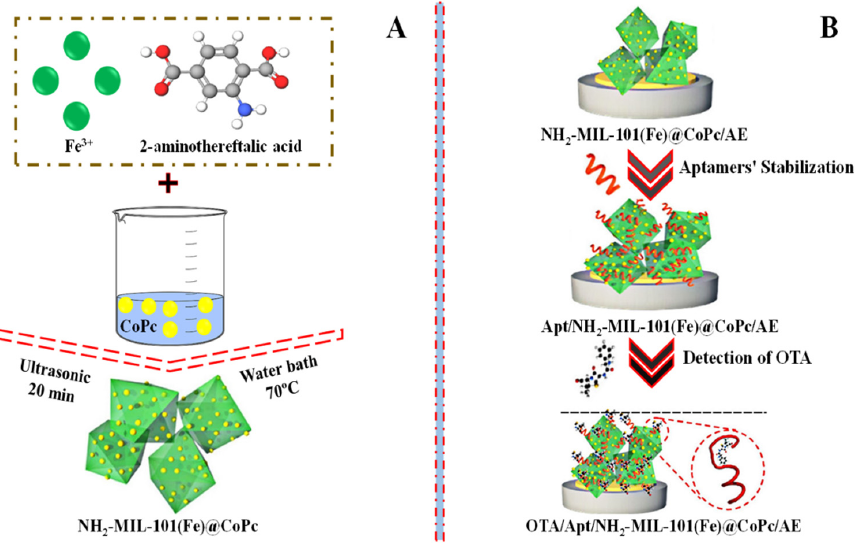
Figure 6. ( A ) Graphical depiction of the synthesis of NH 2 -MIL-101@CoPc nanocomposite and ( B ) the construction of an aptasensor based on NH 2 -MIL-101@CoPc for the detection of OTA. Adapted with permission from the article [68]. 2022, Elsevier.